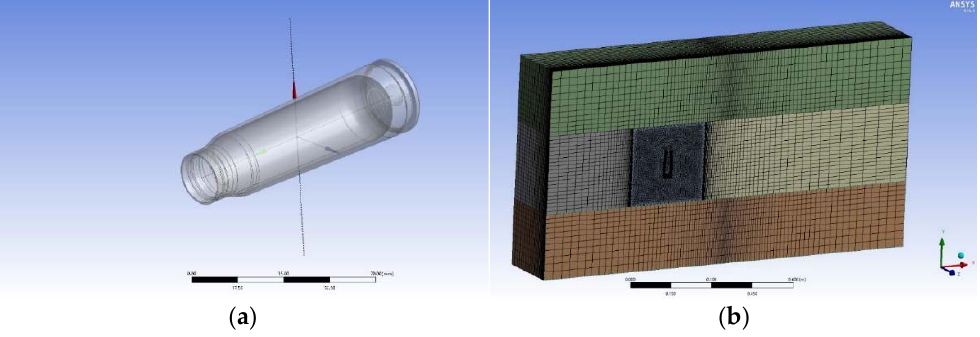
Figure 7. ( a ) Shell case model and ( b ) mesh for calculating drag coefficient.